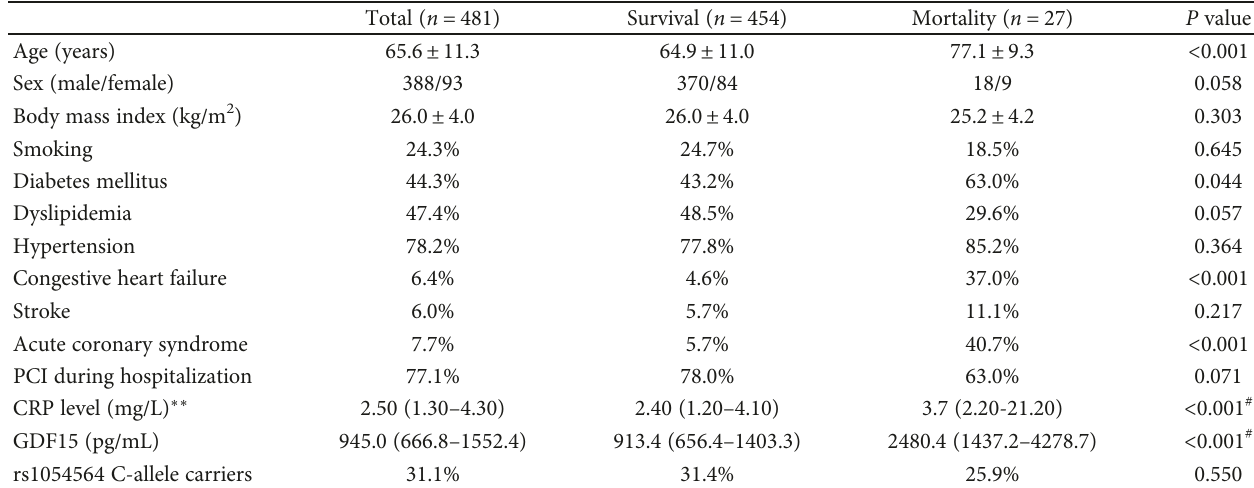
Table 7: Demographics of coronary artery disease patients with or without